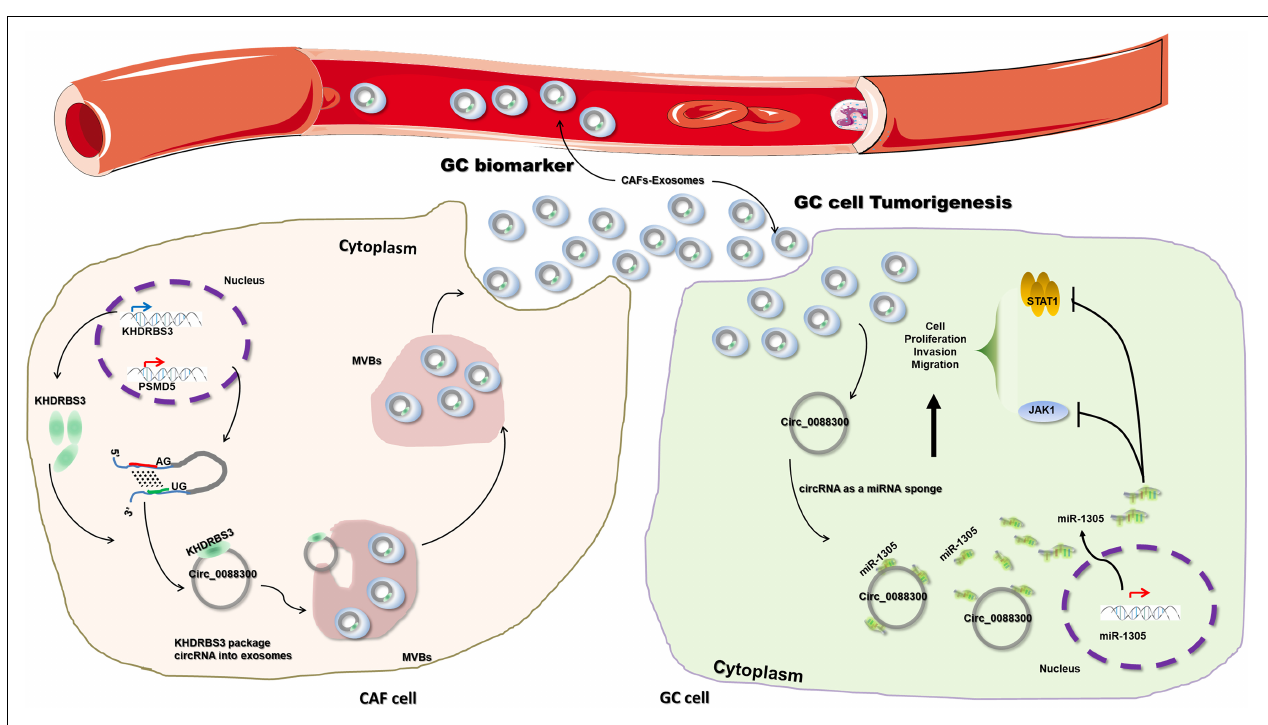
FIGURE 8 | Schematic diagram illustrating the molecular mechanism of circ_0088300 in GC tumorigenesis. Exosomal circ_0088300 derived from cancer-associated fibroblasts acts as a sponge of miR-1305 and promotes gastric carcinoma cell